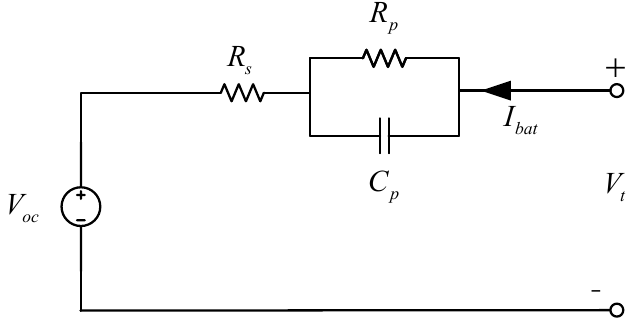
Figure 2. The first-order RC circuit model for